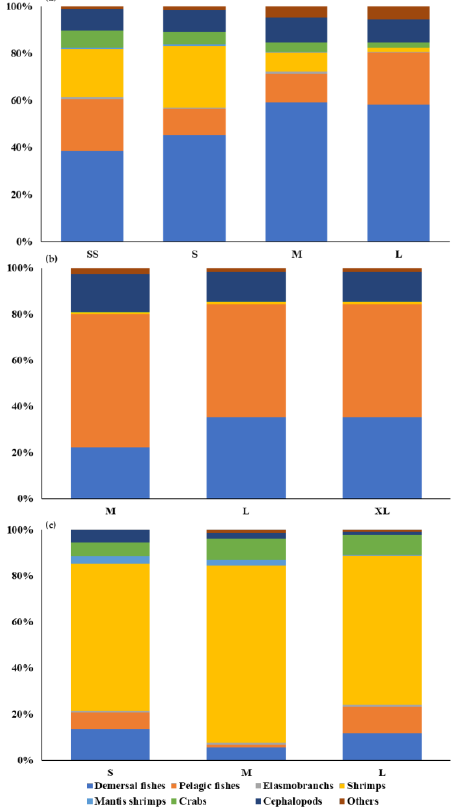
Figure 2. Contribution by taxa groups to catches of trawl fisheries in the Gulf of Thailand, by trawl type and vessel size. Trawl type: ( a ) OBT = Otter-board, ( b ) PT = Pair trawl and ( c ) BT = Beam trawl. Vessel size: SS (<10 gross tonnage, GT), S (10–29.9 GT), M (30–59.9 GT), L (60–149.9 GT) and XL (>150